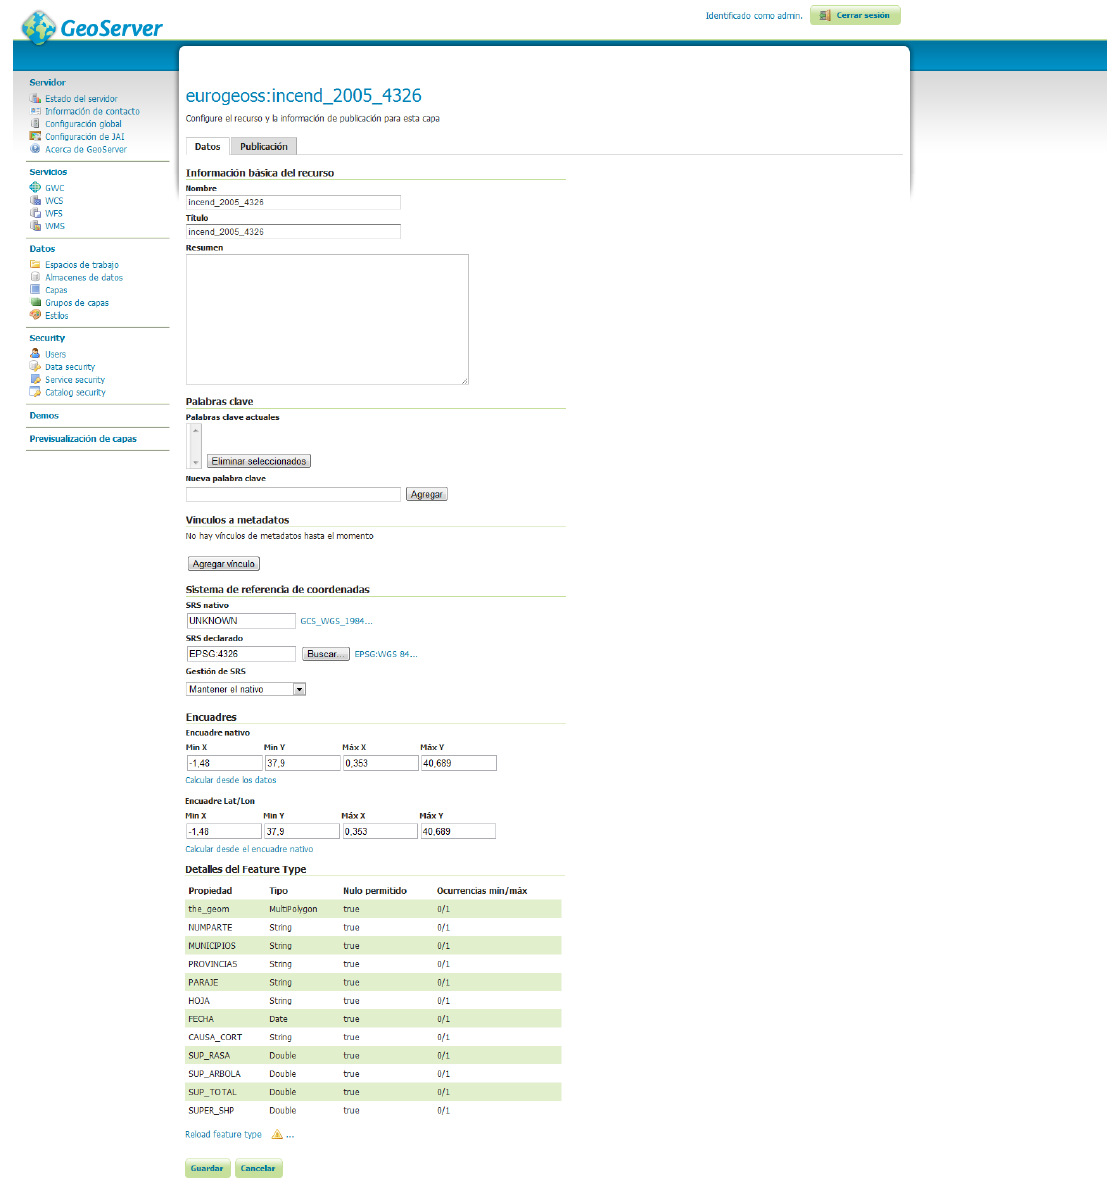
Figure 12. Screenshot of the data published in Geoserver